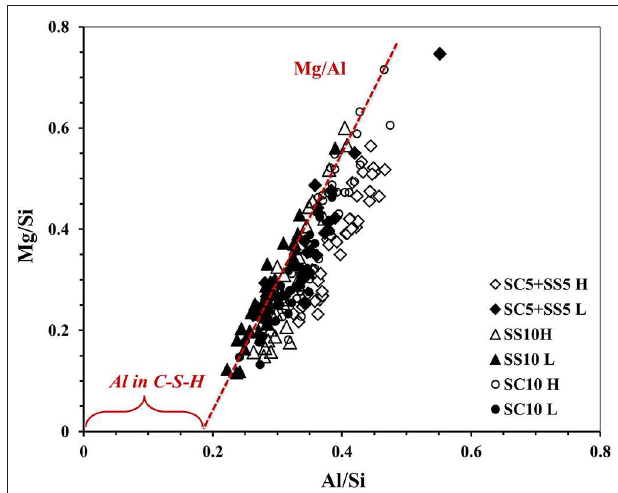
FIGURE 11 | EDX analysis results after 28-day, show atomic ratio Al/Si vs. Mg/Si of AAS concrete, heat, and